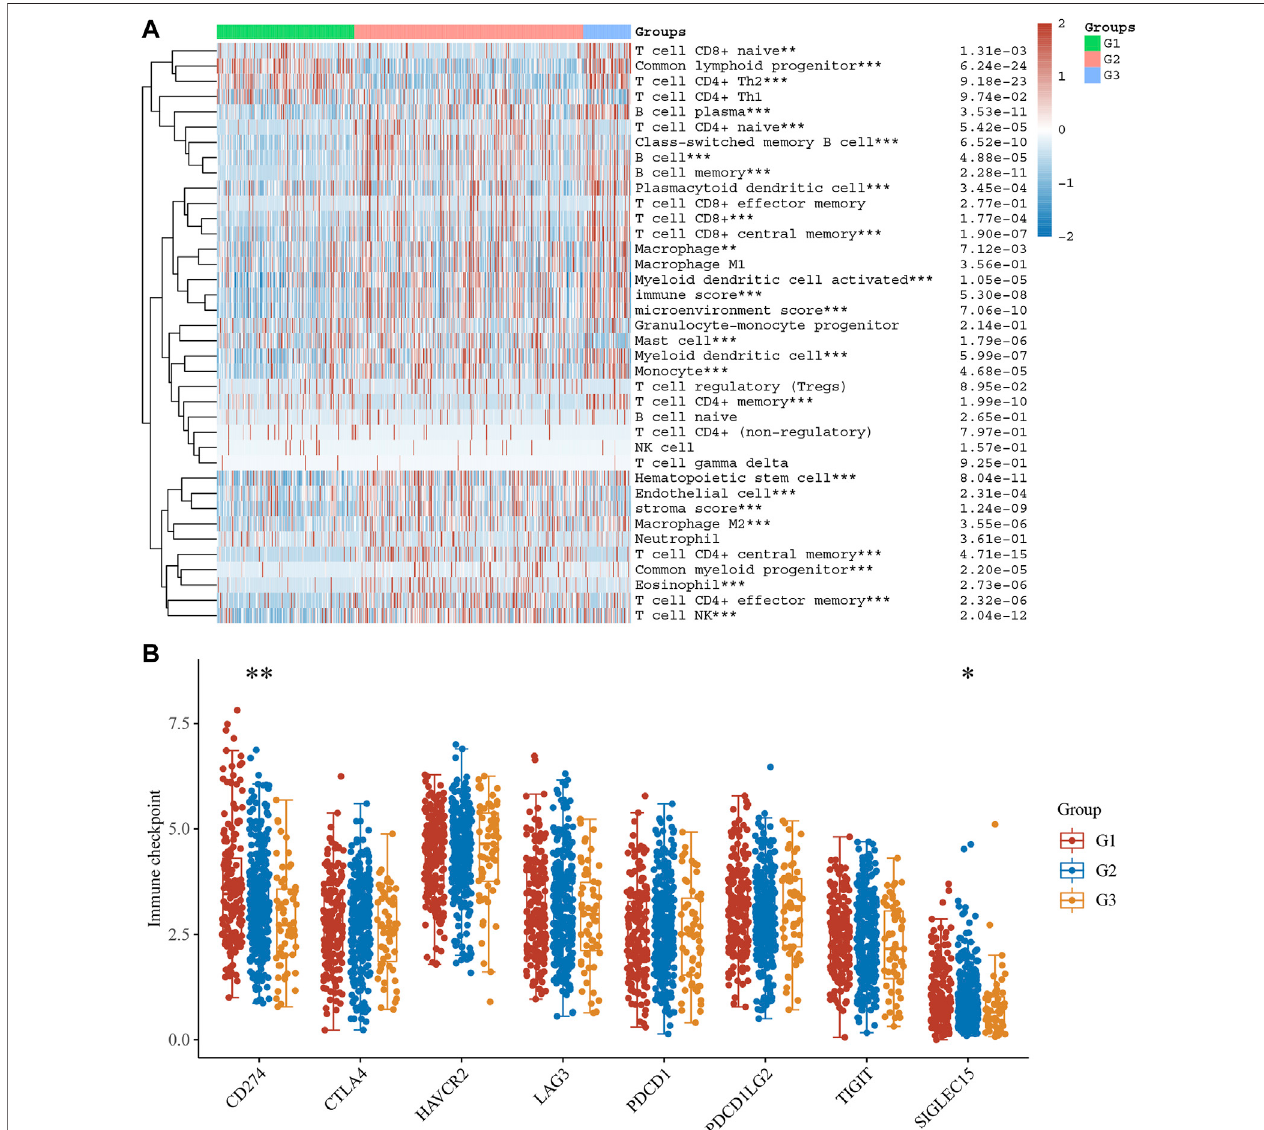
FIGURE8| TheDifferenceinImmuneIn fi ltrationBetweenStressGranuleSubtypes. (A) TheImmuneIn fi ltrationlevelsofdifferentStressGranulerelatedSubtypesin NSCLC were shown. (B) The expression levels of immune regulators among these subtypes of NSCLC were analyzed.